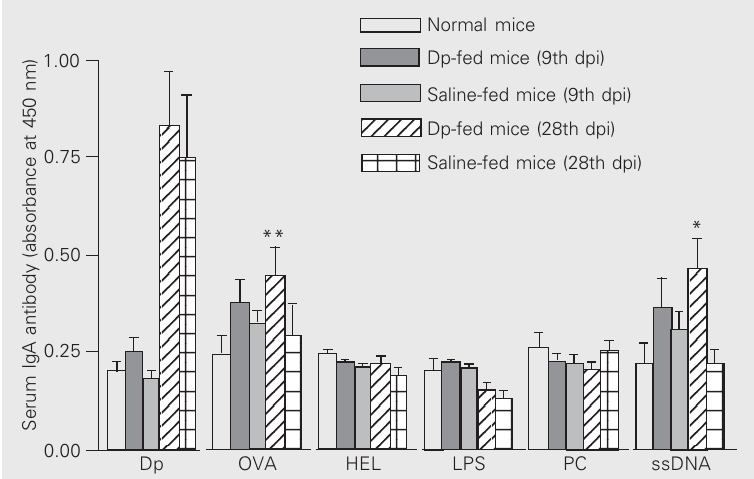
Figure 3. Serum anti- Dermato- phagoides pteronyssinus (Dp) IgA antibody levels of previously sensitized mice fed the Dp ex- tract. A/Sn mice were immu- nized with Dp extract-complete Freund’s adjuvant, fed the Dp extract or saline on the 6th, 7th and 8th days post-immunization (dpi), and boosted on the 21st and 28th dpi. The animals were bled on the 21st, 28th and 35th Figure 4. Reactivity of serum polyreactive IgA antibodies in sensitized mice fed a Dermato- phagoides pteronyssinus (Dp) extract. IgA antibodies present in the sera obtained from Dp ex- tract- and saline-fed mice on the 28th dpi were tested by ELISA against a panel of different anti- gens, i.e., ovalbumin (OVA), hen egg lysozyme (HEL), lipopoly- saccharide (LPS), phosphoryl- ssDNA choline (PC), and ssDNA. Data